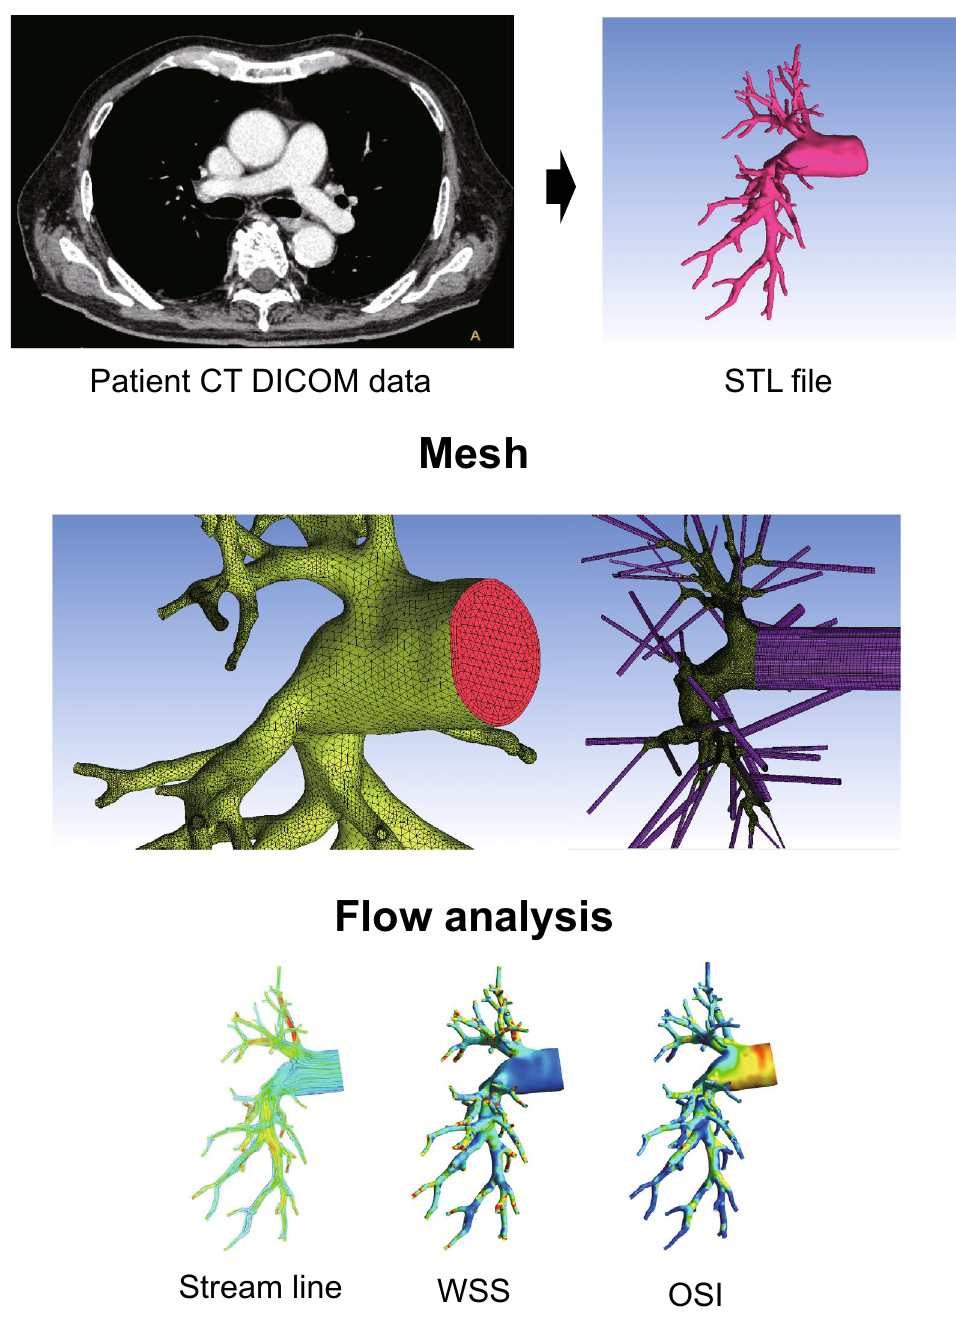
Figure 1. Work process of analysis using computational fluid dynamics. 3D geometries of patient-specific pulmonary arteries in control individuals and patients with CTEPH were generated using computed tomography pulmonary angiography before and after PEA or BPA. After the tetrahedral meshes and boundary- fitted prism layers were created, a CFD simulation was performed to reproduce patient-specific pulmonary artery flow dynamics. CTEPH, chronic thromboembolic pulmonary hypertension; PEA, pulmonary endarterectomy; BPA, balloon pulmonary angioplasty. CT, computed tomography; DICOM, digital imaging and communications in medicine; STL, stereolithography; WSS, wall shear stress; OSI, oscillatory shear